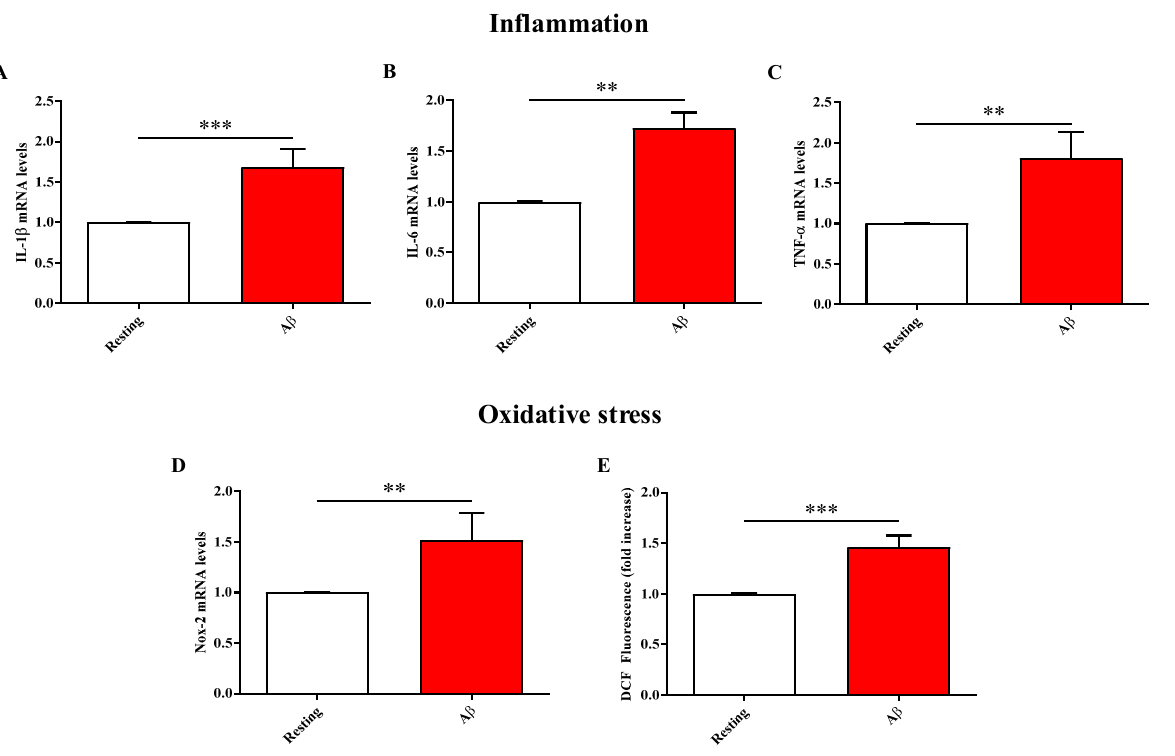
Figure 2. Effects of exposure of ARPE-19 cells to A β 1-42 oligomers (2 µ M) for 48 h on ( A ) IL-1 β , ( B ) IL-6, ( C ) TNF α , ( D ) Nox-2 mRNA expression levels, and ( E ) intracellular ROS levels. The abun- dance of each mRNA of interest was expressed relative to the abundance of GAPDH, as an internal control. Production of ROS is expressed as fold increase with respect to the dichlorofluorescin (DCF) fluorescence measured in resting (control) cells. Values are reported as means of three to four values. Standard deviations are represented by vertical bars. ** significantly different, p < 0.01; *** signifi- cantly different, p < 0.001.